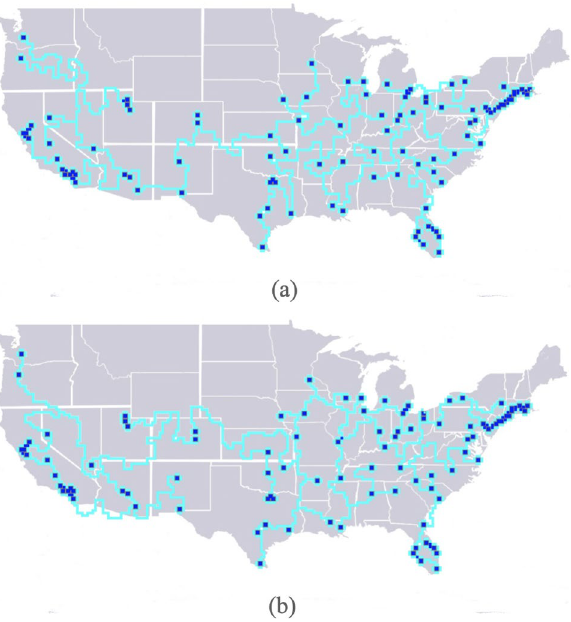
Figure 5. Road network generated by the algorithm. ( a ) shows the final solution with no loops while ( b ) displays a solution that has some redundancy resulting from terminating the algorithm early.